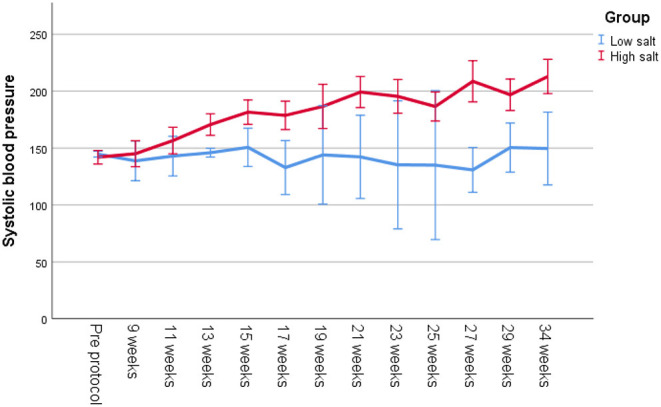
Systolic blood pressure measured with tail cuff on unanesthetized Dahl/SS on a low-salt vs. a high-salt diet throughout the study.